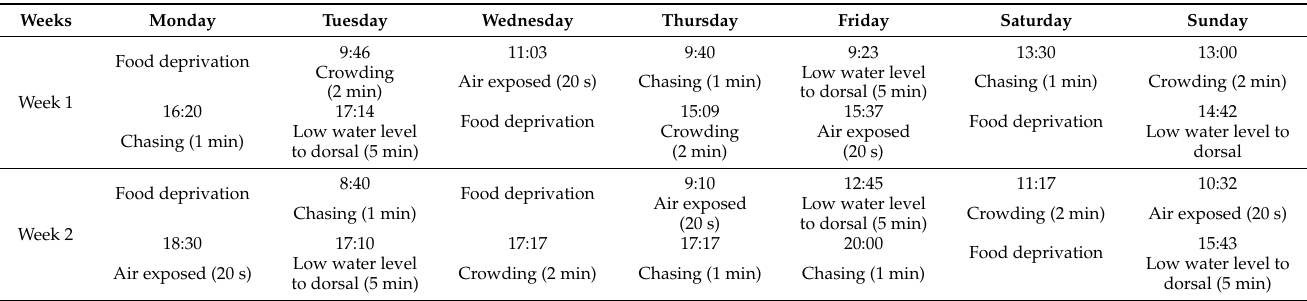
Table 1. Protocol of unpredictable chronic stress. Chasing: use a net to chase the fish. Air exposed: exposed the fish to air. Low water level to dorsal: lower the water level in the rearing tank to the dorsal fin. Crowding: put the 10 fish into the net (14 × 14 × 14